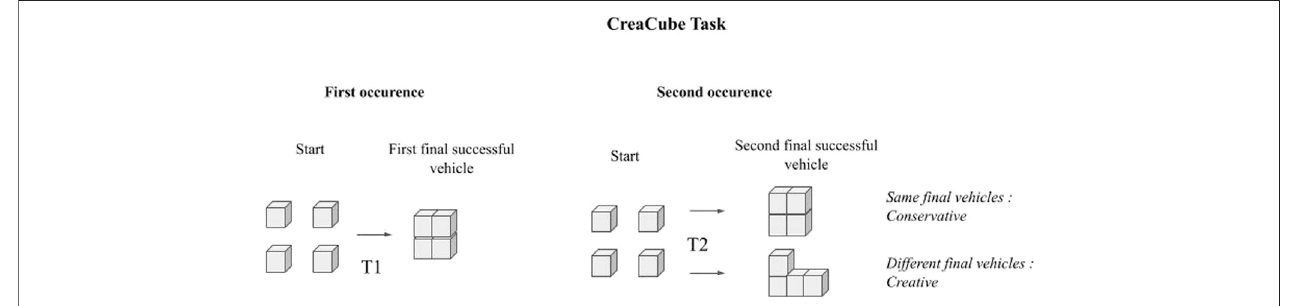
FIGURE 1 | The two stages of the CreaCube